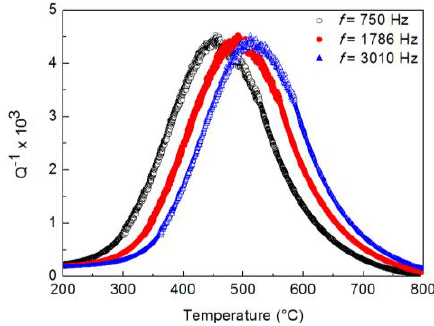
Figure 3. Q −1 peaks obtained in tests with three different resonance frequencies. Figure 3. Q − 1 peaks obtained in tests with three different resonance